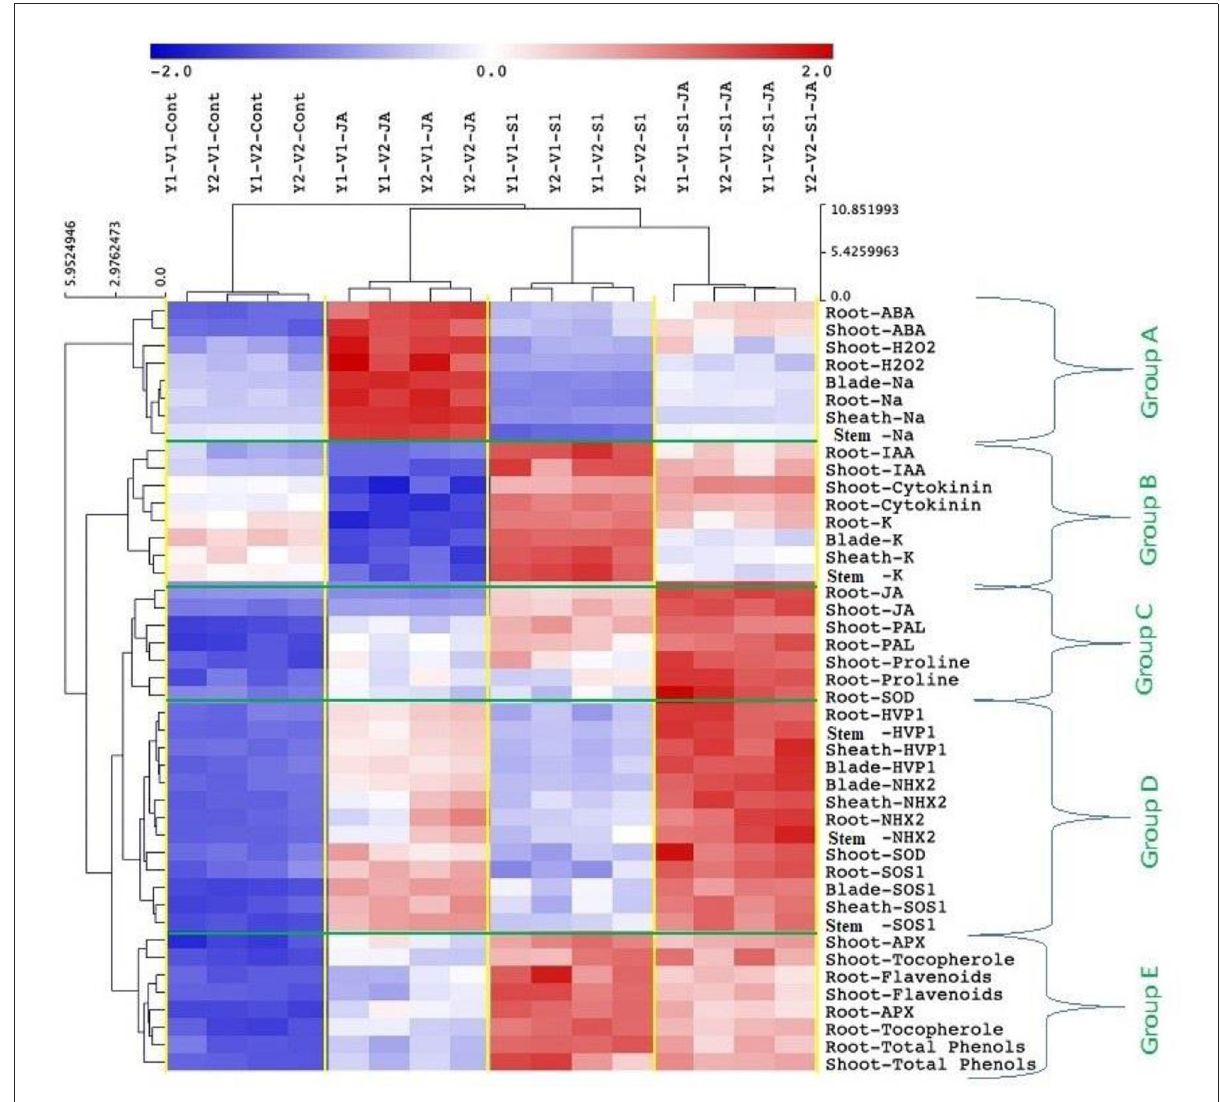
FIGURE7 Cluster analysis showing data correlation clustered the metabolic activities to five clusters; Group A) included ABA (shoot and root), H 2 O 2 (shoot and root), Na + content (root, shoot, blade, and sheath), Group B) included IAA (shoot and root), cytokinins (shoot and root), and K + (root, stem, blade, and sheath), Group C) included JA (shoot and root), PAL (shoot and root), proline (shoot and root), and SOD activity of roots, Group D) included the expression of genes HVP1 , NHX2 , and SOS1 of stem, root, leaf sheath, and leaf blade, as well as the SOD activity in the shoot, and Group E) included APX activity (shoot and root), tocopherol (shoot and root), flavonoids (shoot and root), and total phenol (shoot and root). ABA, abscisic acid; IAA, indole acetic acid; JA, jasmonic acid; PAL, phenylalanine ammonia-lyase; SOD, superoxide dismutase; APX, ascorbate